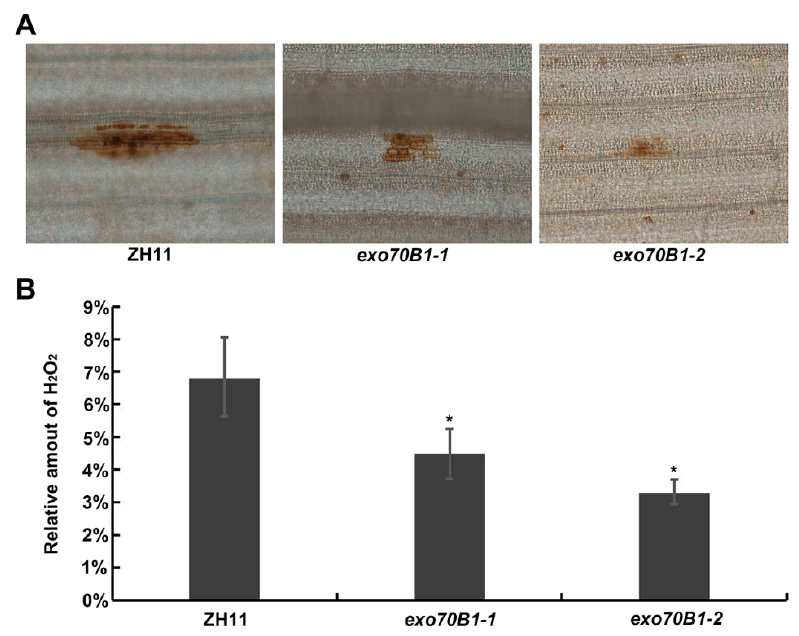
Figure 5. Accumulation of H 2 O 2 is lower in exo70B1-1 and exo70B1-2 mutants compared to the wild type. ( A ) DAB (3,3 ′ -diamino-bezidine) staining at infection sites of exo70b1-1 , exo70B1-2 and ZH11 plants 2 days post-inoculation (dpi). Darker staining indicates accumulation of H 2 O 2 . ( B ) Relative amount of H 2 O 2 was calculated based on pixels taken with ImageJ using the following formula: H 2 O 2 area per rectangle = pixel of H 2 O 2 area per leaf / pixel of rectangle. Data are represented as the mean ± standard error of mean (SEM). Asterisks represent significant di ff erences (* p < 0.05, Student’s t -test). Bar = 10 µ